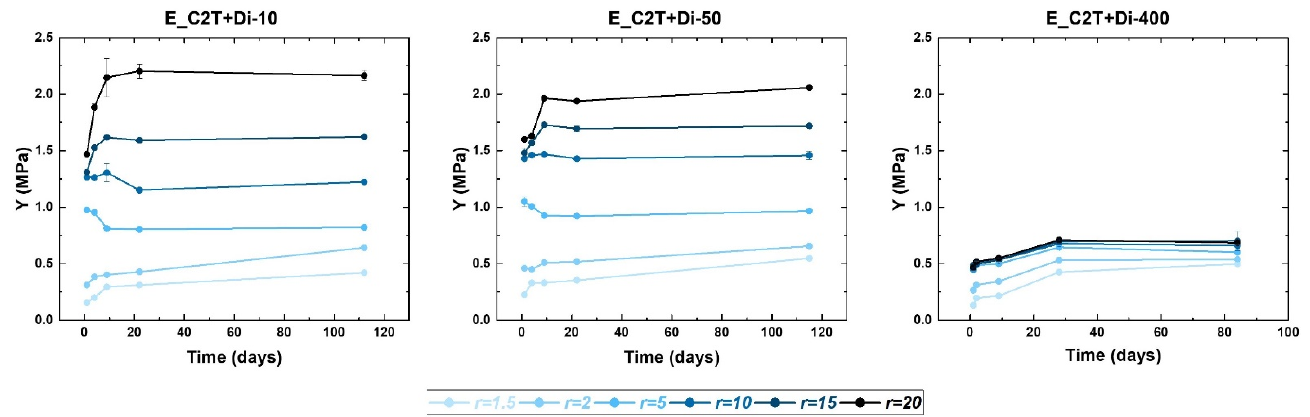
Figure 3. Stability of elastomer films assessed via change in Young´s modulus over time. The elastomers were prepared via the reaction between C2T and Di-10, Di-50, and Di-400, respectively. The stoichiometric ratio was varied from 1.5 to 20. Film thickness was ~100 µm.